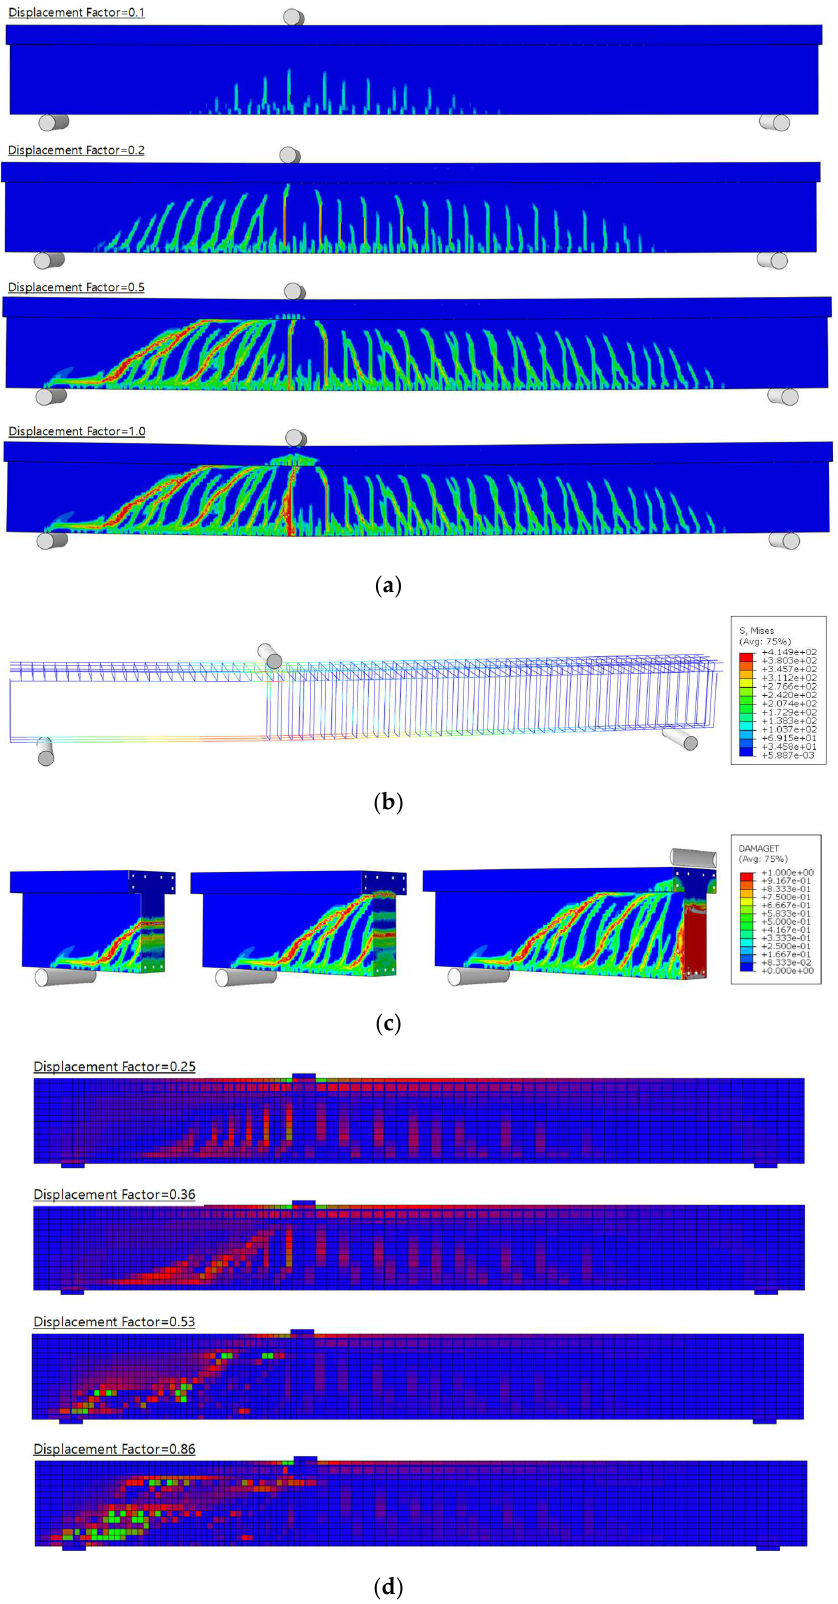
Figure 6. Failure patterns of the SFRC T-beam under the three-point bending test. ( a ) Crack patterns of ABAQUS. ( b ) von-Mises stress in the reinforcements. ( c ) Tensile damage. ( d ) Crack patterns of